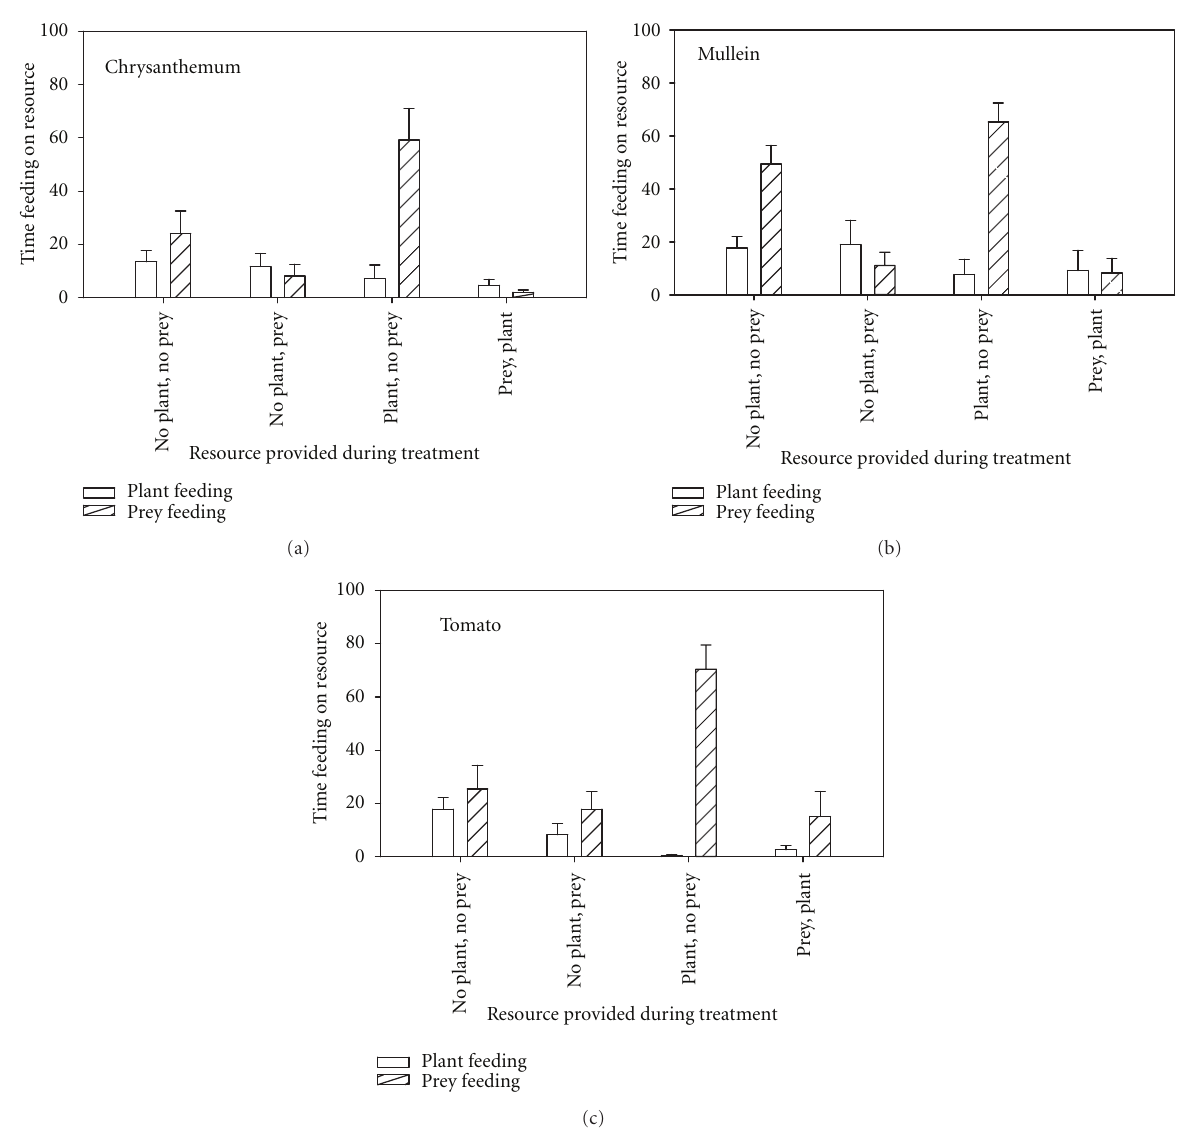
Figure 1: Mean total time spent in (a) plant and prey feeding during a 2h observation interval and (b) proportion of feeding time that was plant feeding by Dicyphus hesperus females after 24h experimental periods with or without access to plant tissue and/or prey.